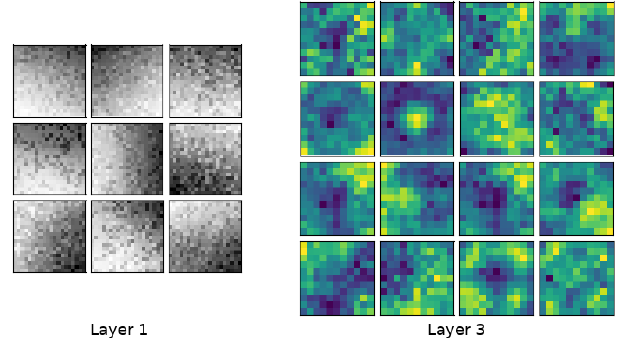
Figure 11. Typical weights learned in the first and last convolu- tional layers. Weights learned from the third layer are shown using the same color map as the snow freeboard in Fig. 7 to facilitate comparison. Darker colors indicate lower weights, but the actual values are not important. The filters in layer 1 correspond to edge detectors, e.g., Sobel filters, and the filters in layer 3 may be higher- order morphological features like “bumps” (snow dunes) and linear, strand-like features (ridges). The filter size of the first layer corre- sponds to 4.0m (20 pixels at 0.2m resolution) and the third layer is 8.8m (11 pixels at 0.8m resolution). The resolution is halved at each layer due to the stride of 2 (see Fig.